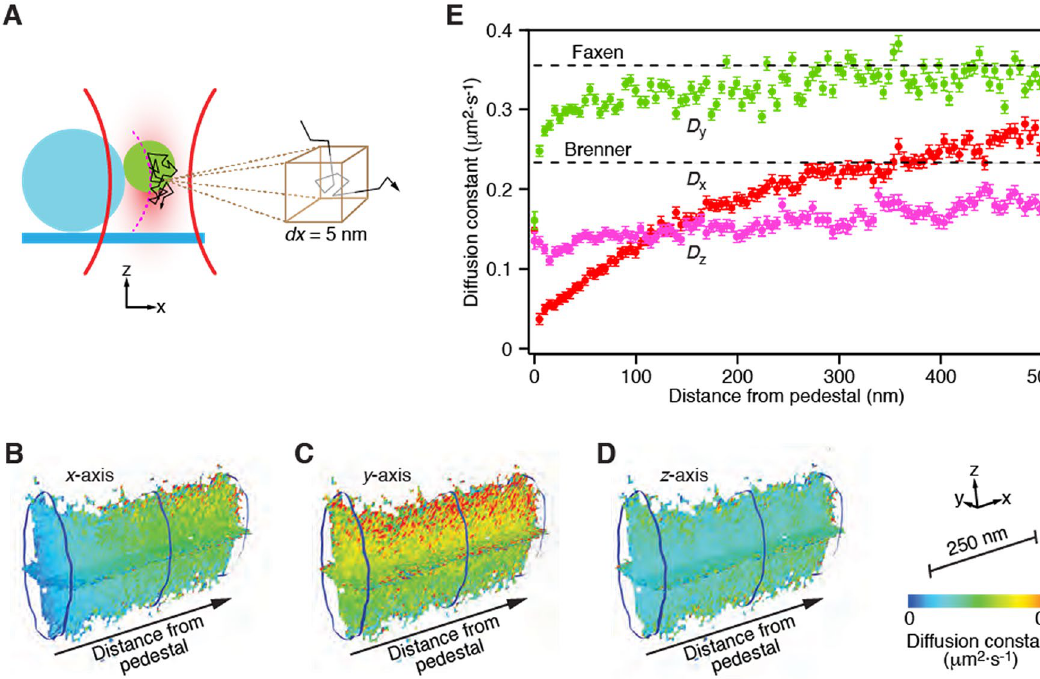
Figure 3. Measurement of local diffusion constants. ( A ) A schematic diagram depicts measurement of the mean squared displacement for a probe centered in a 5 nm voxel. ( B ) A heat map shows local diffusion constants along the x -axis as a function of the probe’s position along each of the three indicated axes. The definition of axes, spatial scale, and calibration are shown at the bottom right of the figure and pertain to the next two panels as well. ( C ) Another map portrays the local diffusion constants along the y -axis. ( D ) A similar representation displays the local diffusion constants along the z -axis. ( E ) The local diffusion constants along the three axes display strikingly different behaviors. The values D x for motion along the x -axis decrease sharply as the probe approaches the pedestal. Diffusion along the y -axis, parallel to the coverslip, yields values D y relatively insensitive to position. The diffusion constants D z for movement along the z -axis are reduced by proximity to the coverslip. These data are identical to those along the x -axes of the three preceding heat maps. The error bars represent weighted standard errors of the